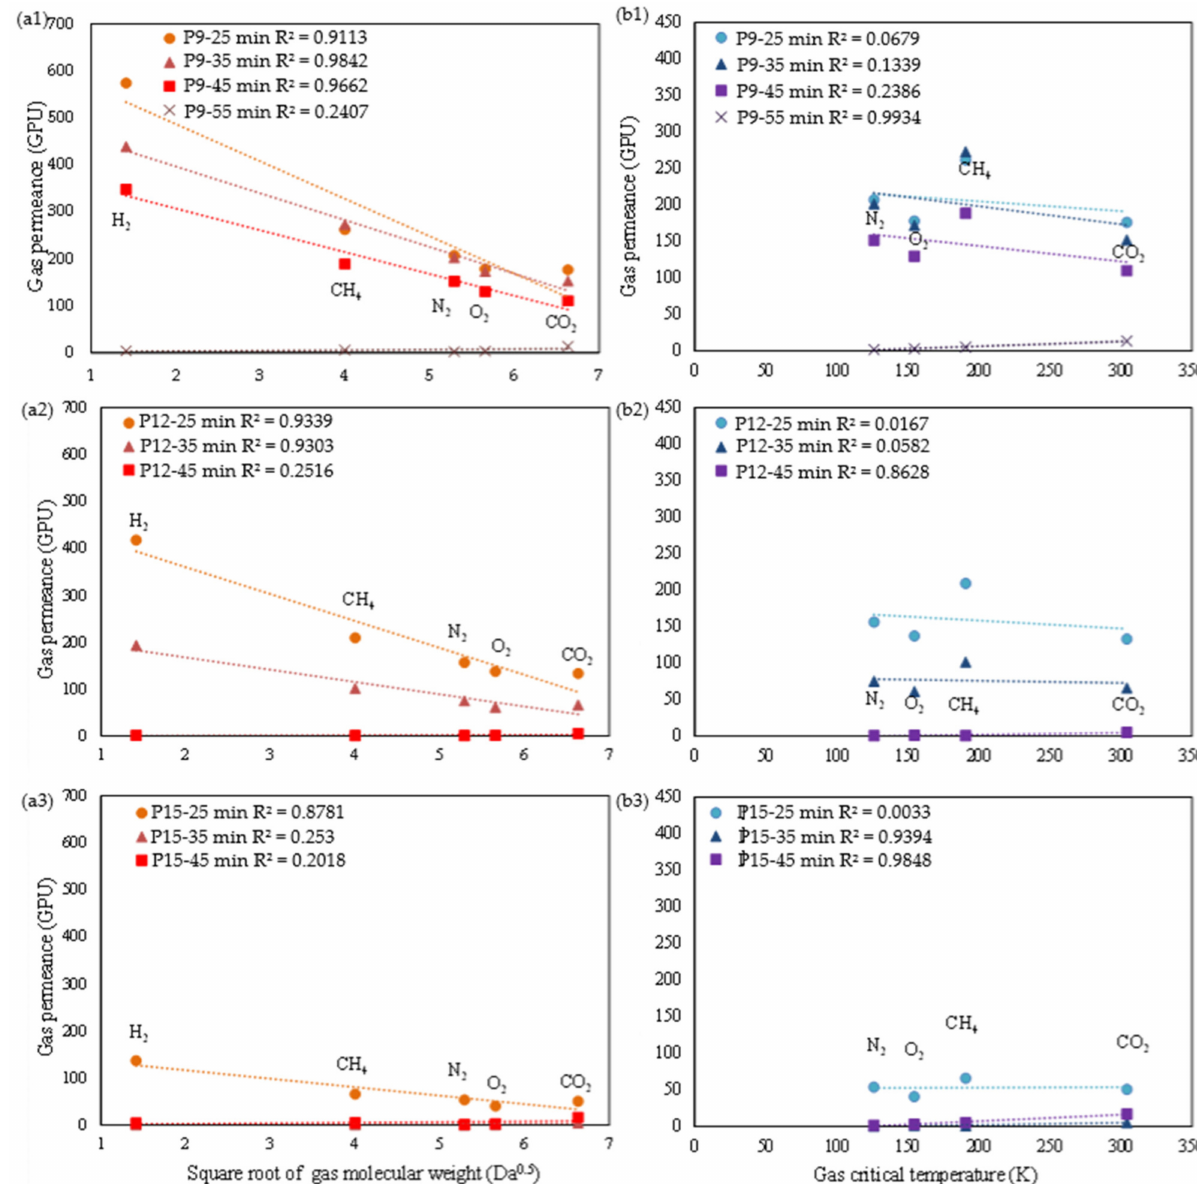
Figure 6. Correlation analysis between single gas permeance and ( a ) the square root of the gas molecular weight and ( b ) the gas critical temperature for the hybrid PDMS membranes: ( a1 , b1 ) P9, ( a2 , b2 ) P12, and ( a3 , b3 )